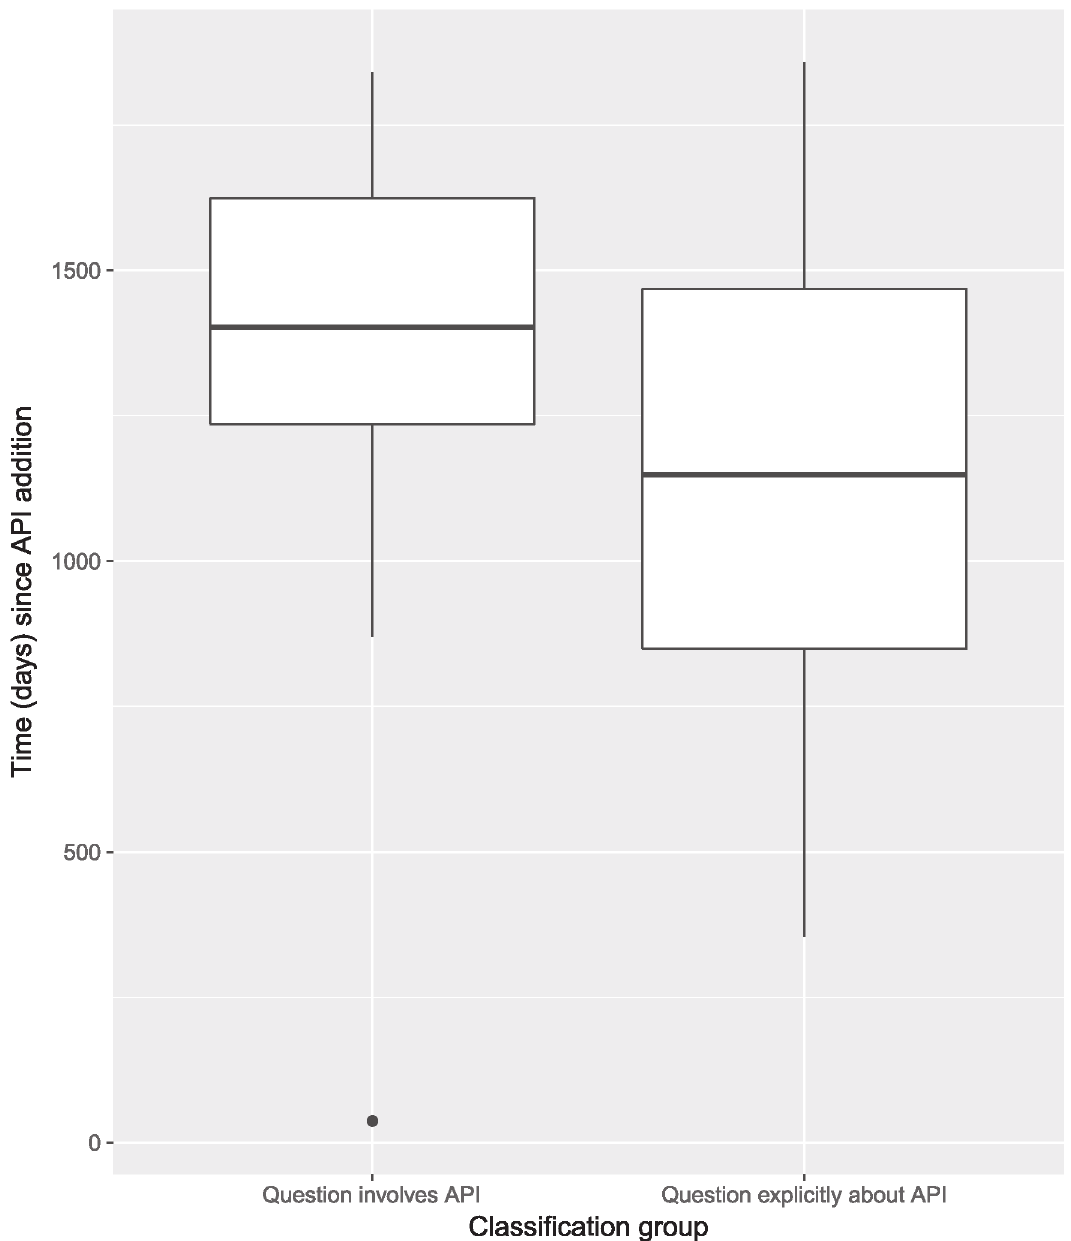
Fig 3. Time since API addition for 50 question case study, per manual classification group (2-sided t-test p < 0.05; 2-sided Wilcoxon rank-sum test p <